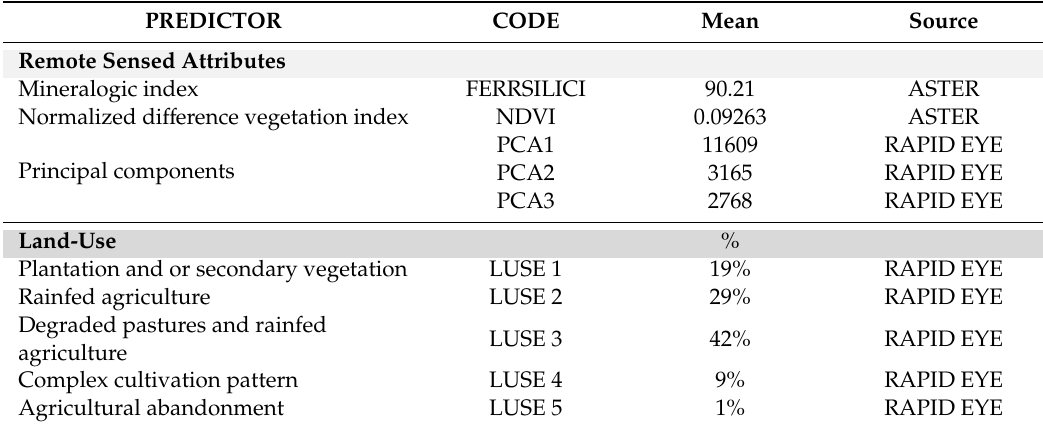
Table 1. Remote sensing derived